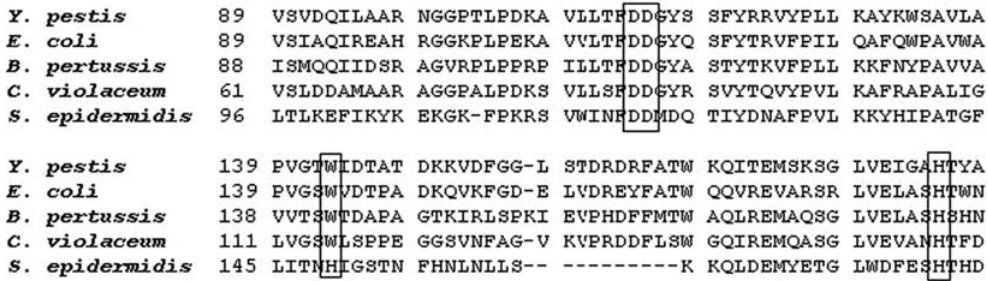
Figure 3 - Multiple partial alignment of HmsF of C. violaceum compared with PgaB of E. coli; IcaB of S. epidermidis ; HmsF of Y. pestis and HmsF of B. pertussis . The critical residue to extracellular matrix formation in Y. pestis : D (aspartate), W (tryptophan) and H (histidine) are